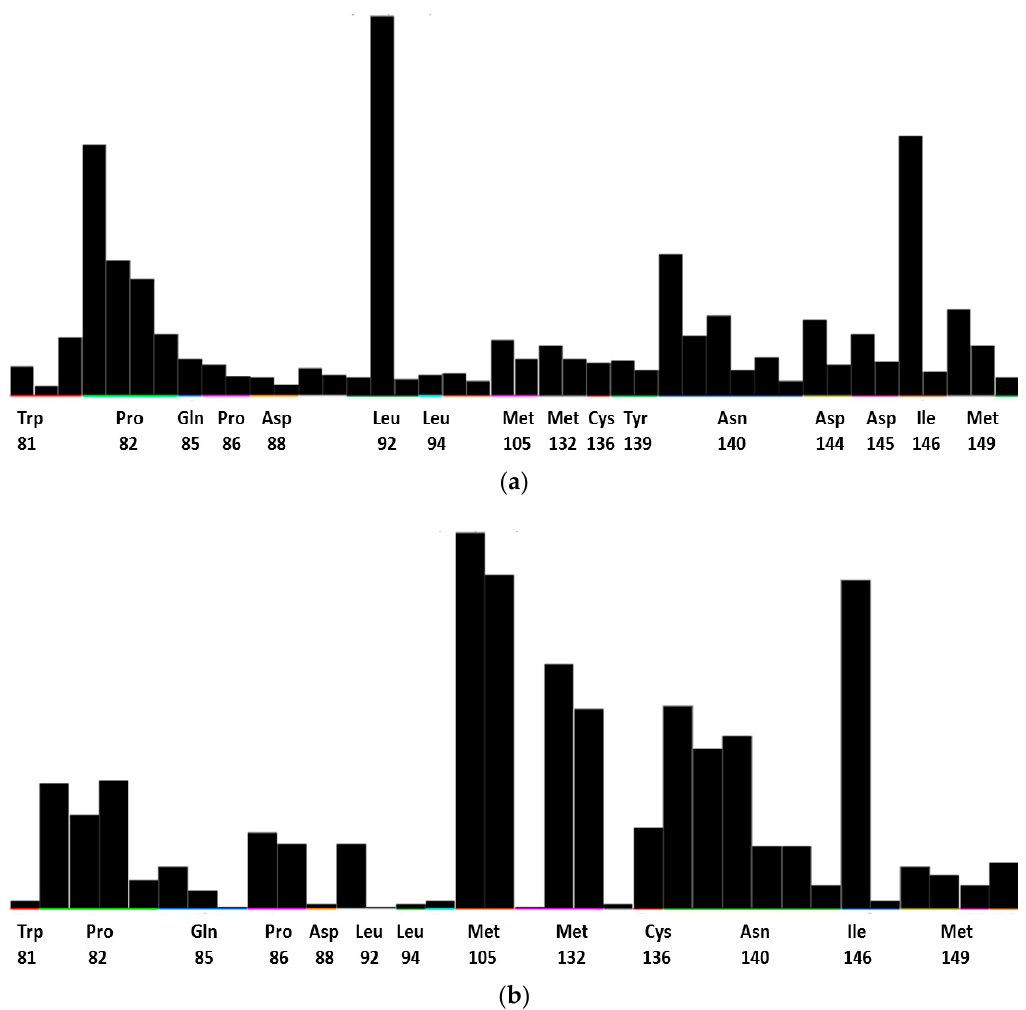
Figure 4. Consensus protein–ligand interaction fingerprint obtained from a consensus analysis of the docking with the Autodock Vina, LeDock, MOE, and PLANTS programs. ( a ) Amentoflavone; ( b ) Fisetin.